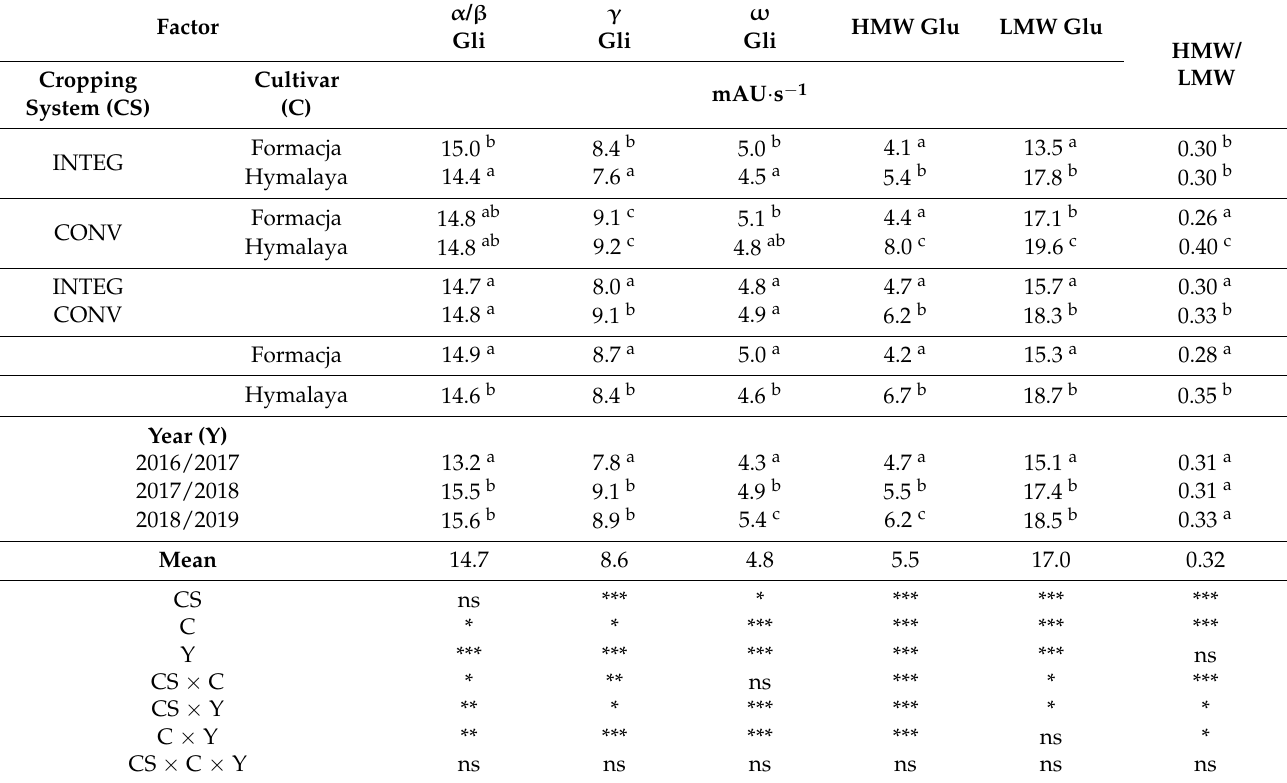
Table 5. Effect of cropping system and cultivar on the protein fractions of gliadins and